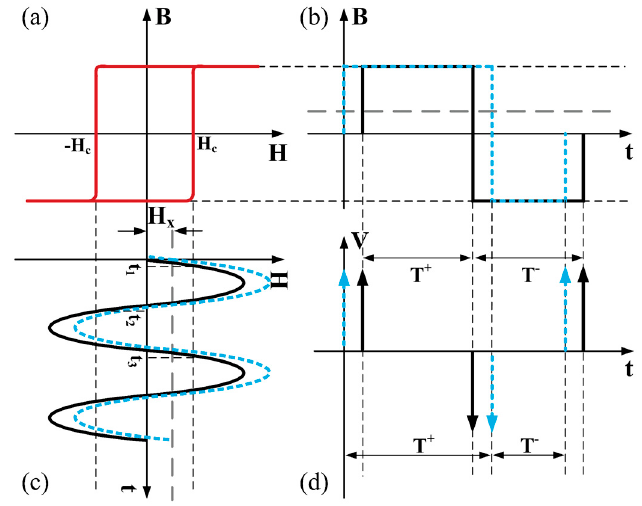
Figure 2. Schematic diagram of the working principle of RTD fluxgate magnetometer. ( a ) Ideal square hysteresis loop, ( b ) magnetic induction intensity corresponding to the hysteresis loop in ( a ), ( c ) sinusoidal excitation signal of an RTD fluxgate with and without a target magnetic field, and ( d ) induced voltage signal from sensing coil with and without a target magnetic field.